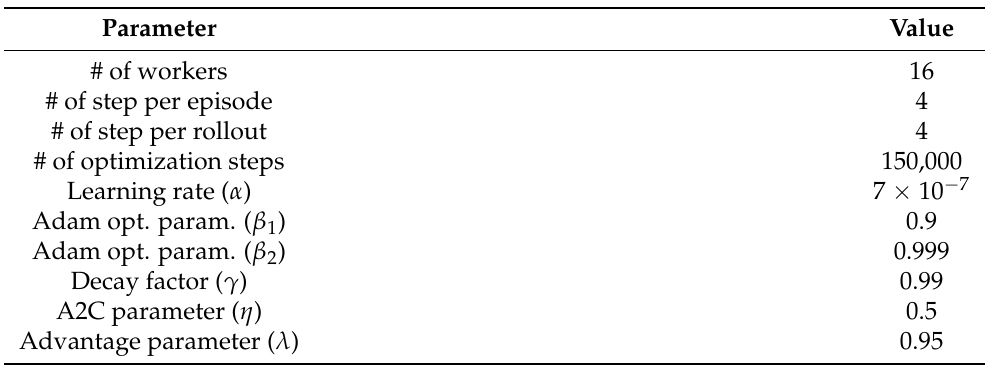
Table 3. List of training